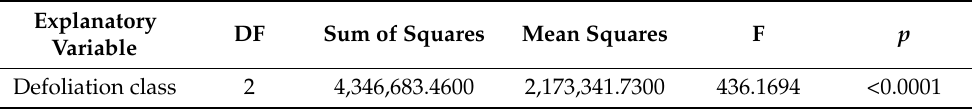
Table 4. Summary statistics for differences between number of trees per hectare depending on the defoliation class (ANOVA one way).